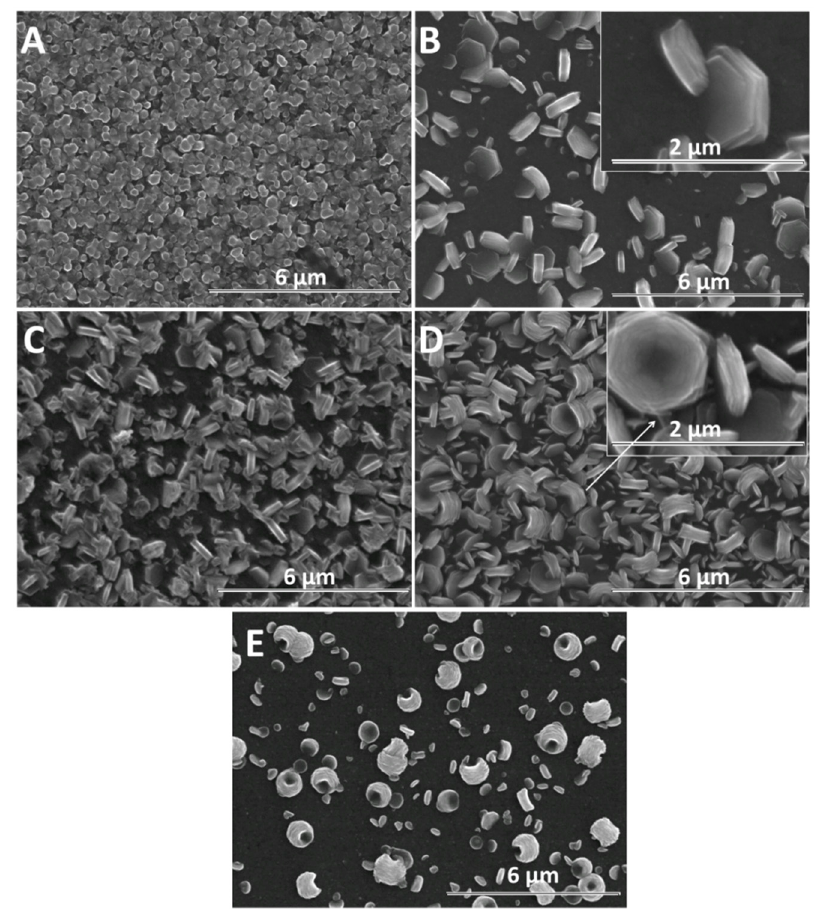
Figure 6. SEM images of ZnO electrodeposited as a function of GO content (mg L − 1 ) at − 0.8 V for 600 s: 0 ( A ), 2.5 ( B ), 7.5 ( C ), 10 ( D ). SEM image of ZnO electrodeposited in the presence of 10 mg L − 1 GO at − 0.7 V for 600 s ( E ).